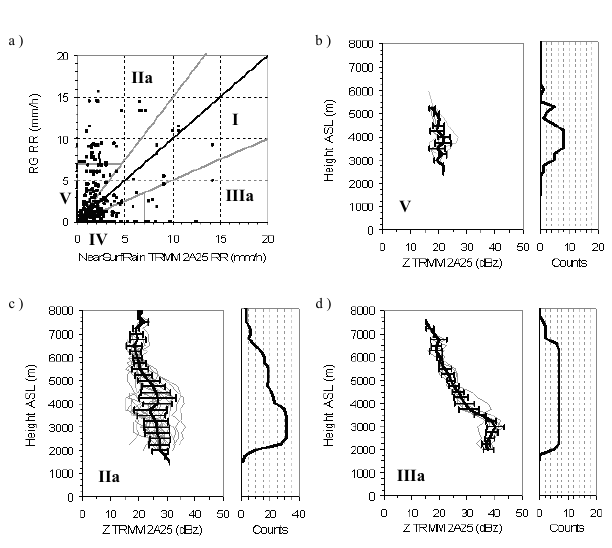
Fig. 6: TRMM 2A25 reflectivity profiles. a) TRMM profiles classification into five categories (I-II- Fig. 6. TRMM 2A25 reflectivity profiles. (a) TRMM profiles classification into five categories (I-II-III-IV-V) and 2 subcategories (IIa-IIIa). Selected TRMM profiles: (b) V (448). (c) IIa (31). (d) IIIa